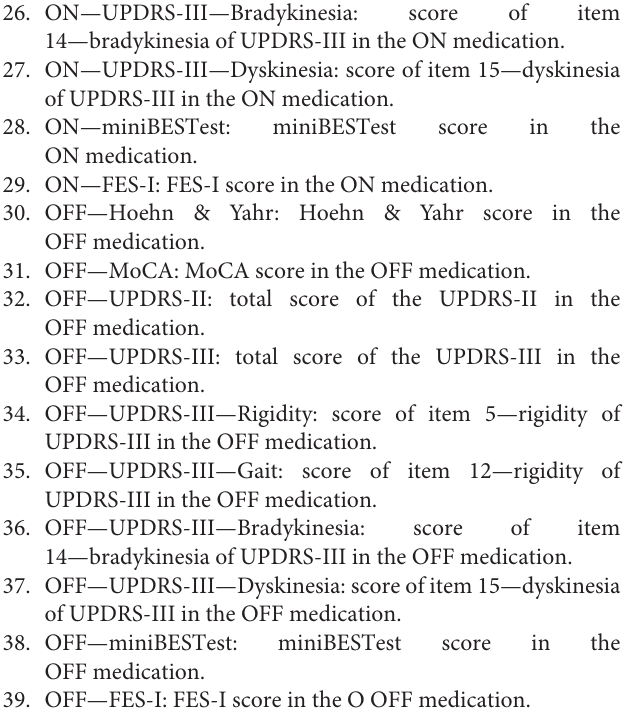
balance of PD patients. All the data is available at Figshare (doi: